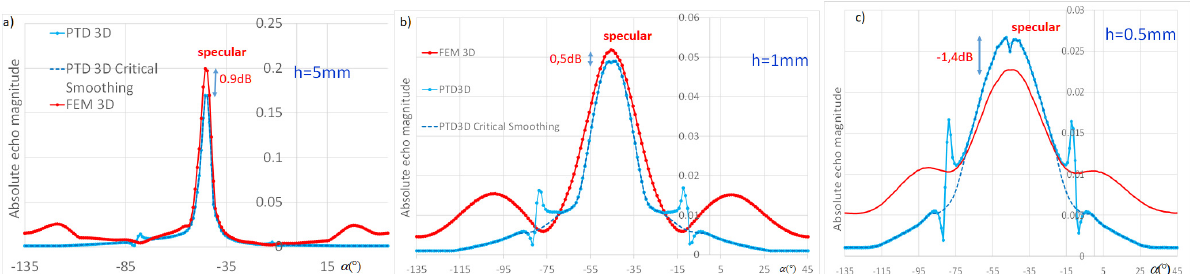
Figure 7. A planar component containing an embedded rectangular flaw of 0.5 mm extent and of height: ( a ) 5, ( b ) 1 and ( c ) 0.5 mm. Comparison of FEM and PTD (standard or with smoothing around the critical angle) models.